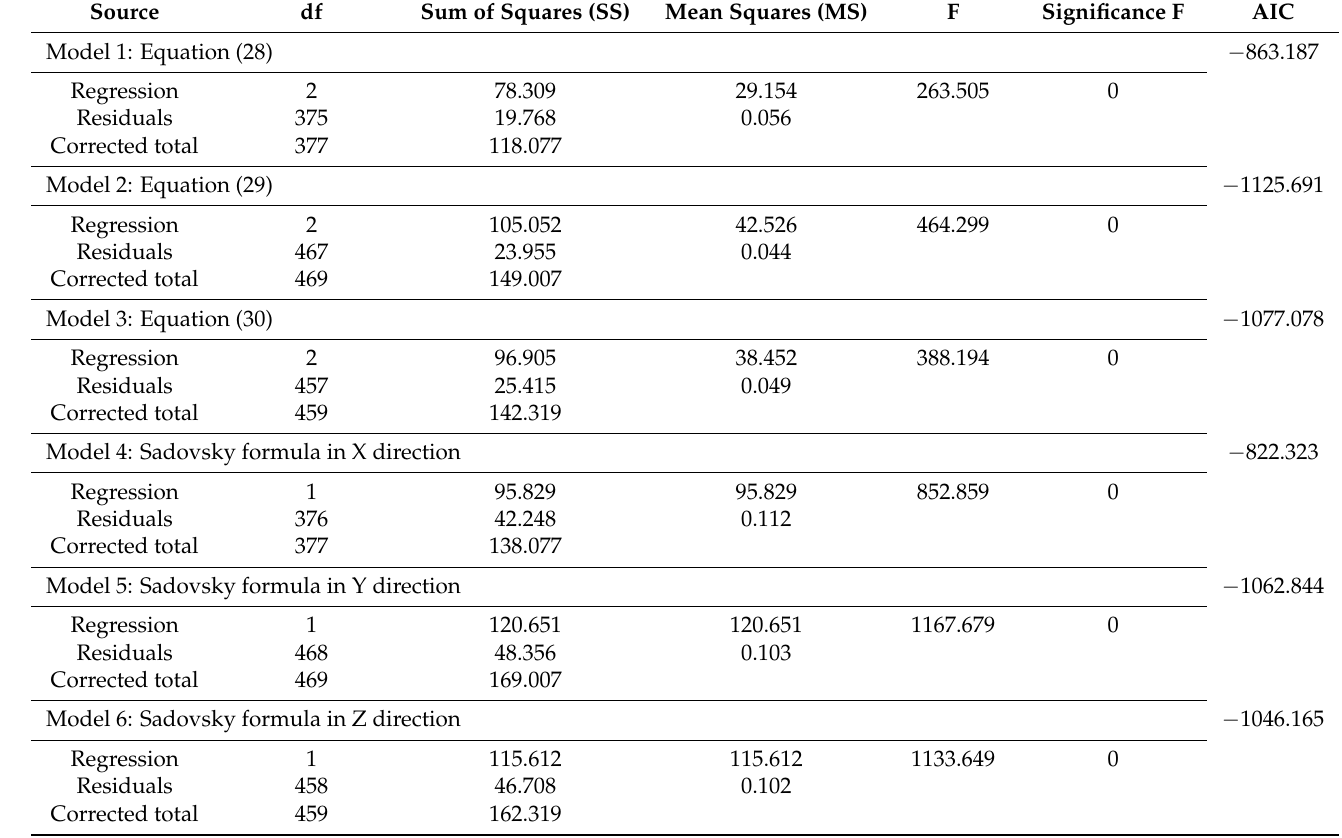
Table 3. The ANOVA and AIC results for six